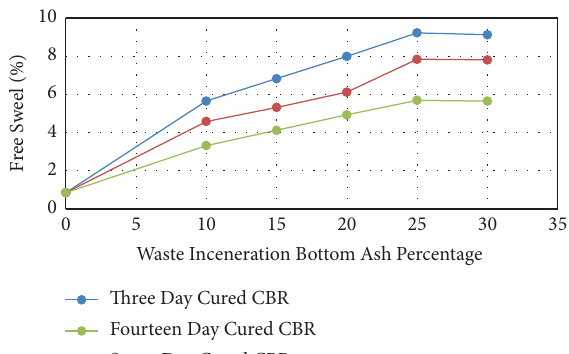
Figure 6: Efect of waste incineration bottom ash content and curing period on Californian Bearing Ratio (CBR) of subgrade soil.